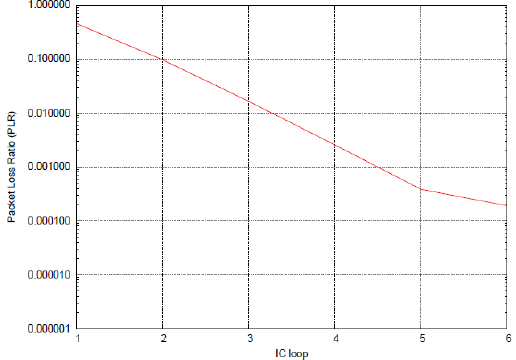
Figure 15. PLR trend with SIC, case TFI#25.